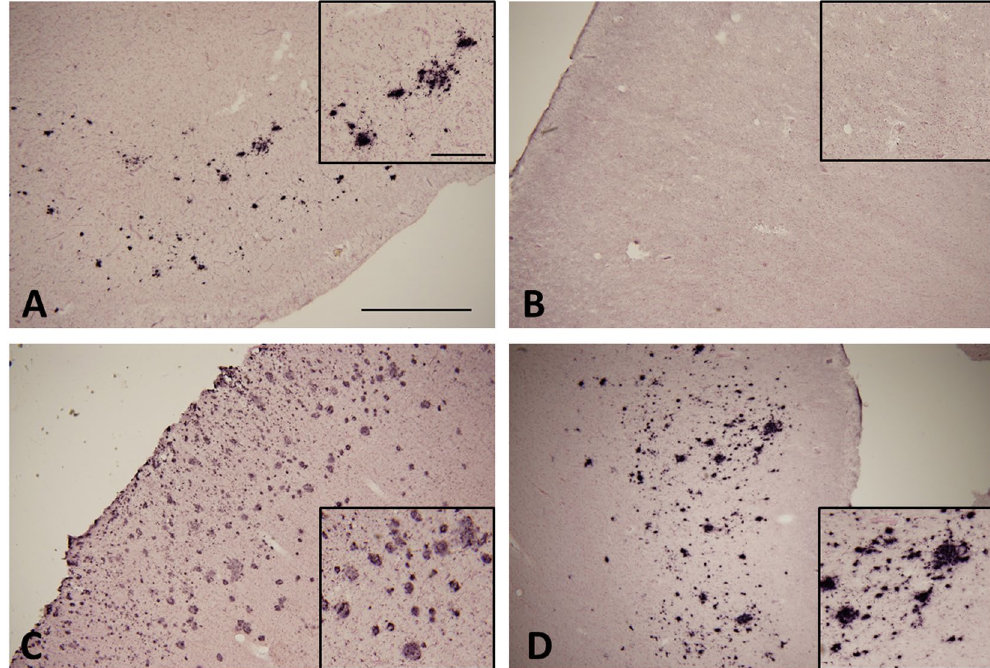
Figure 4. Immunohistochemical staining of amyloid β in the temporal lobe of GRN mutation cases. Amyloid β (A β ) was observed in cases 1 ( A ), 3 ( C ) and 4 ( D ), but not in case 2 ( B ). Most A β -positive structures consisted of diffuse plaques. The scale bar in ( A ) applies to all photomicrographs (1.0 mm) and the scale bar in insert A applies to insert ( B – D ) (250 μ